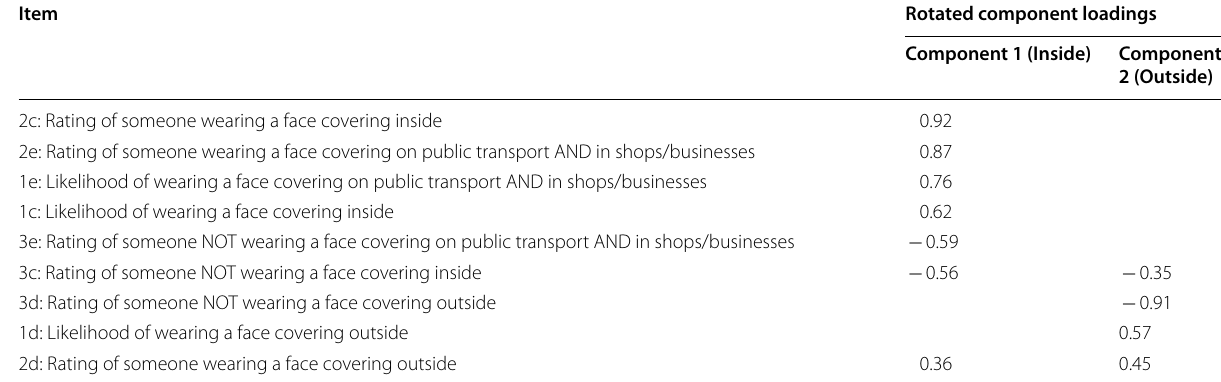
Table 7 Rotated component loadings for each item in the attitude questionnaire